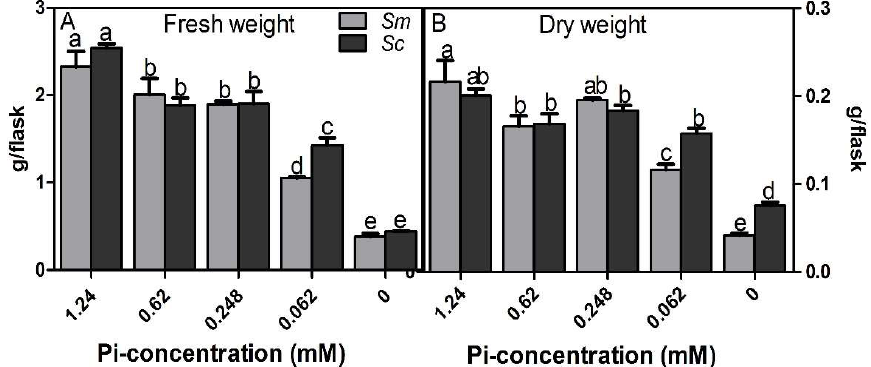
Figure 1. Biomasses of hairy roots in different inorganic phosphate (Pi) concentration conditions. ( A ) The fresh weight. ( B ) The dry weight. Sm , S. miltiorrhiza ; Sc , S. castanea . Different letters indicate significant differences by applying Duncan’s multiple range test.